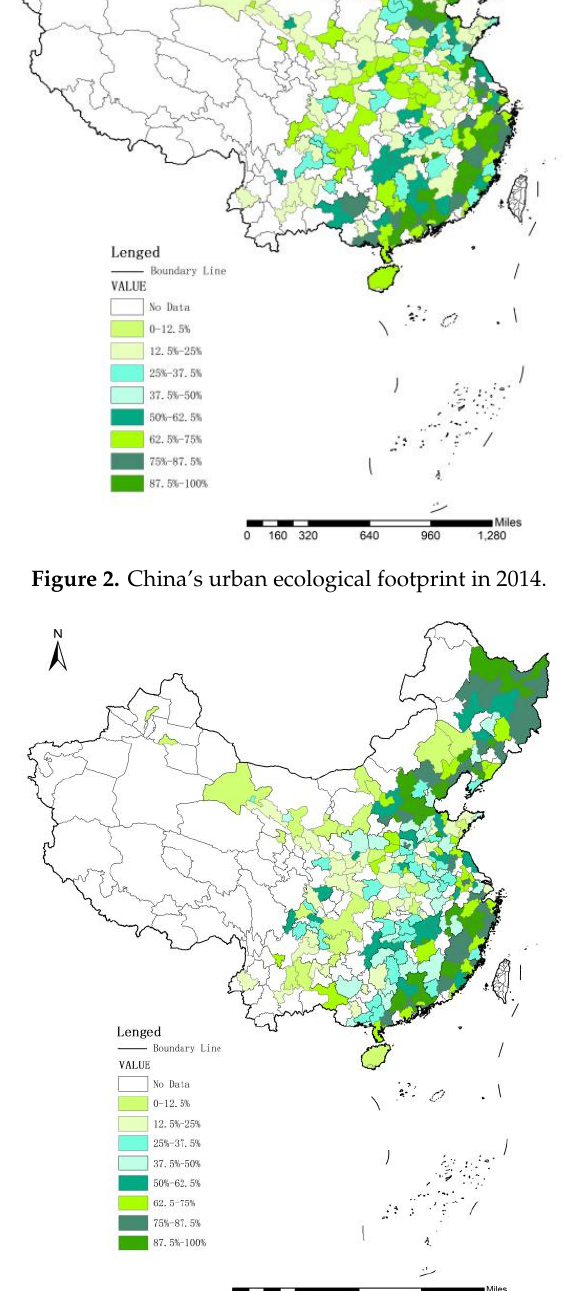
Figure 3. China’s urban ecological footprint in